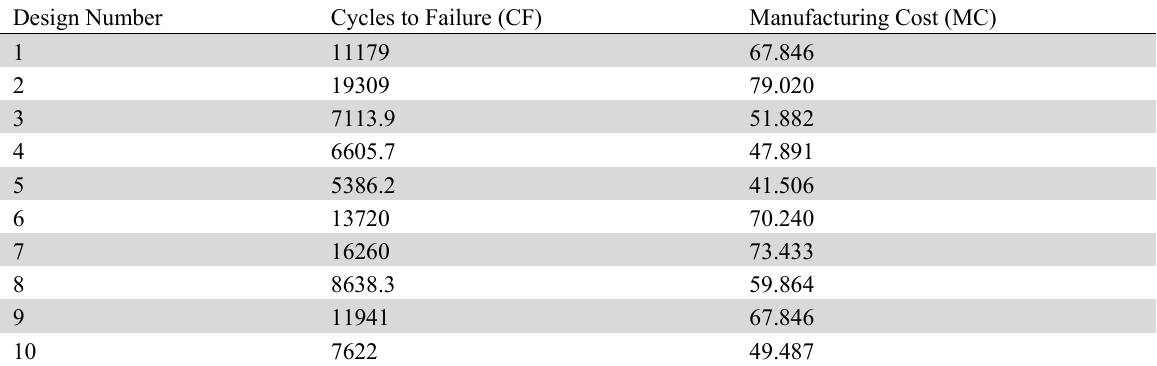
The root-weighted decision matrix Design Number